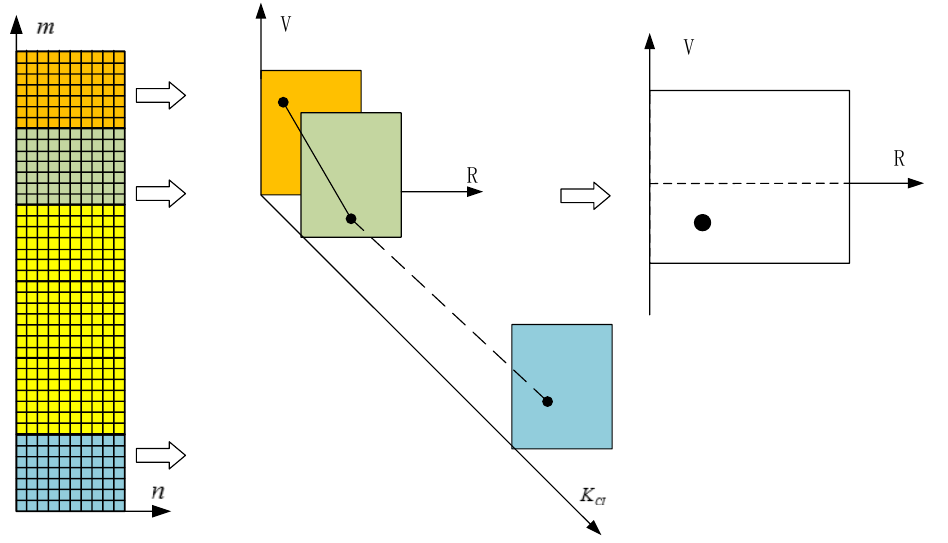
Figure 3. Diagrammatic drawing for hybrid integration.